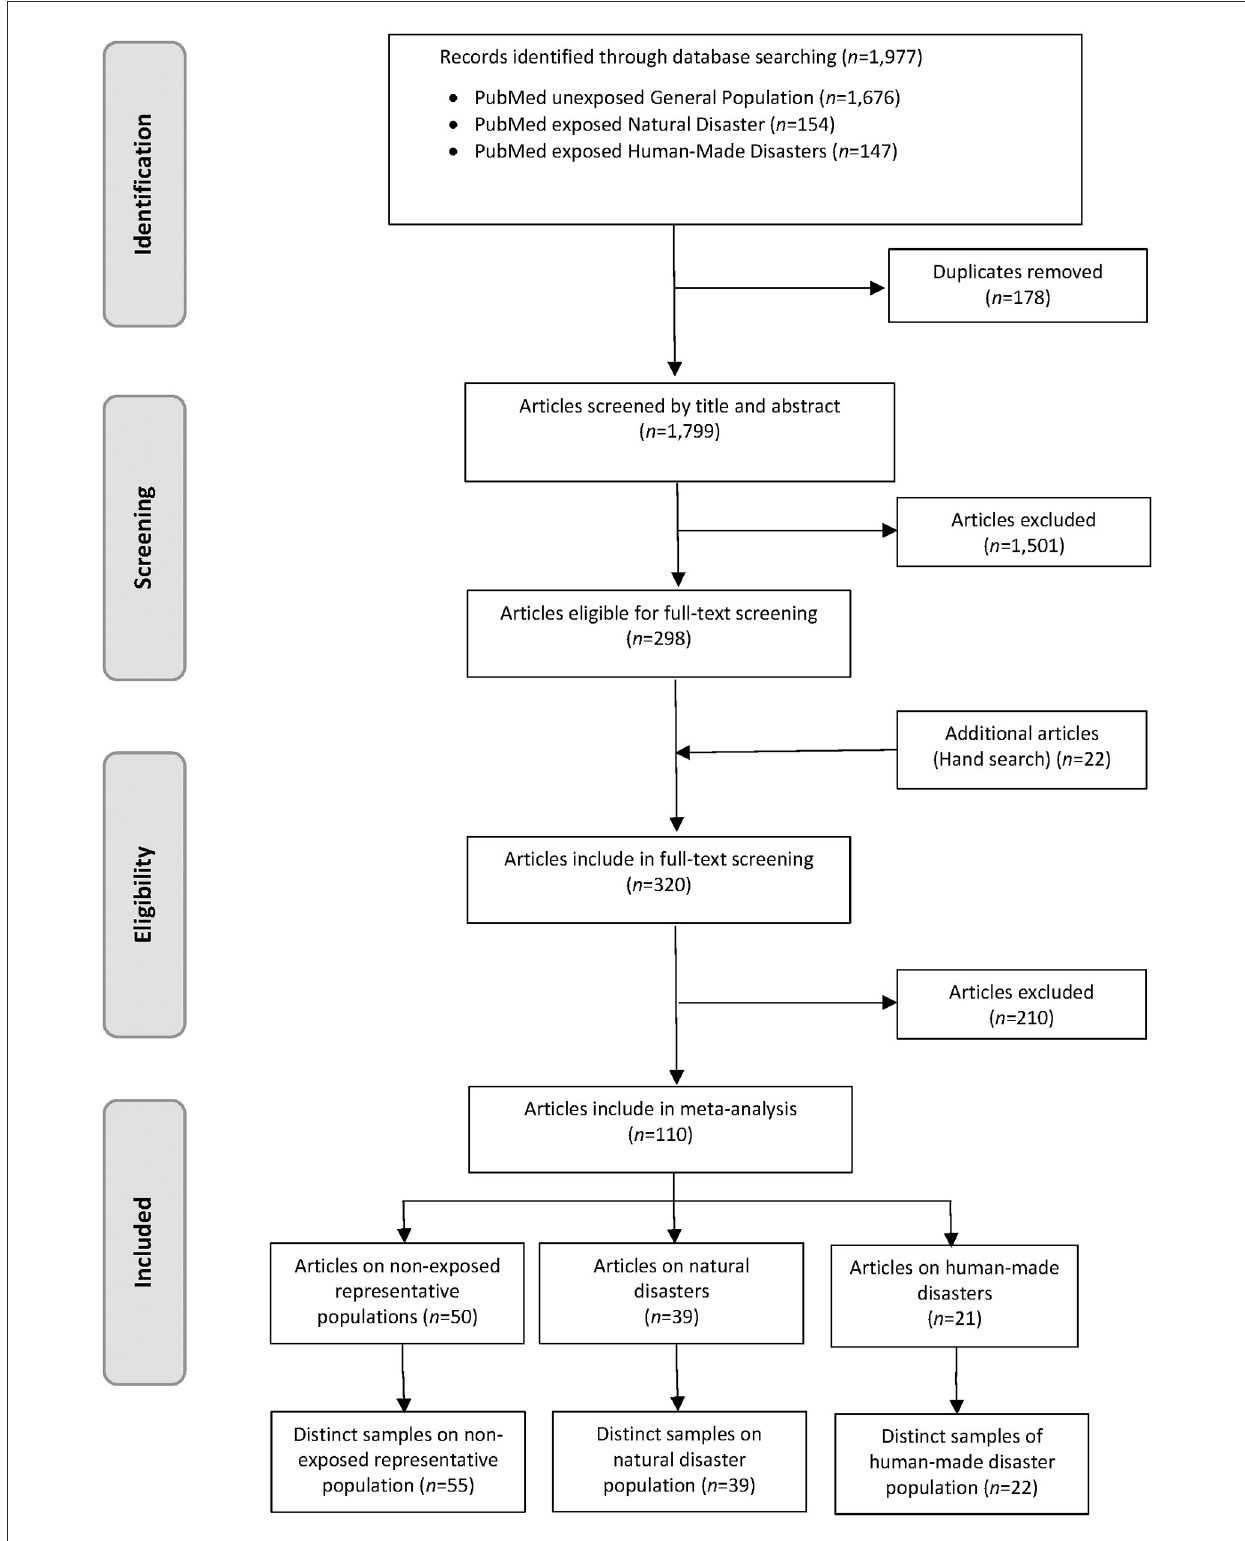
FIGURE2 Flow diagram of the screening and study selection process of general populations of employable age.